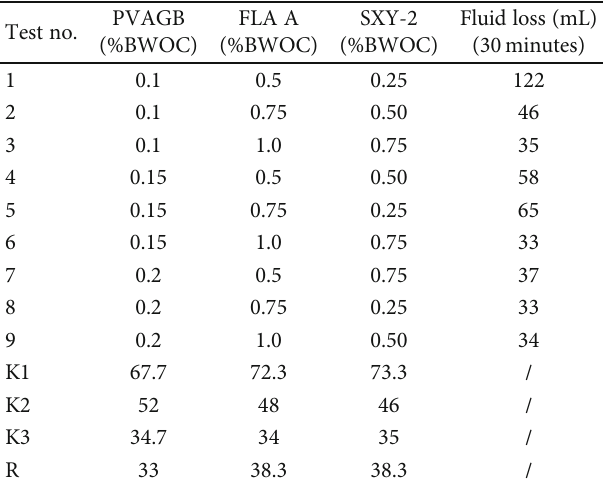
Table 4: Fluid loss test 2.